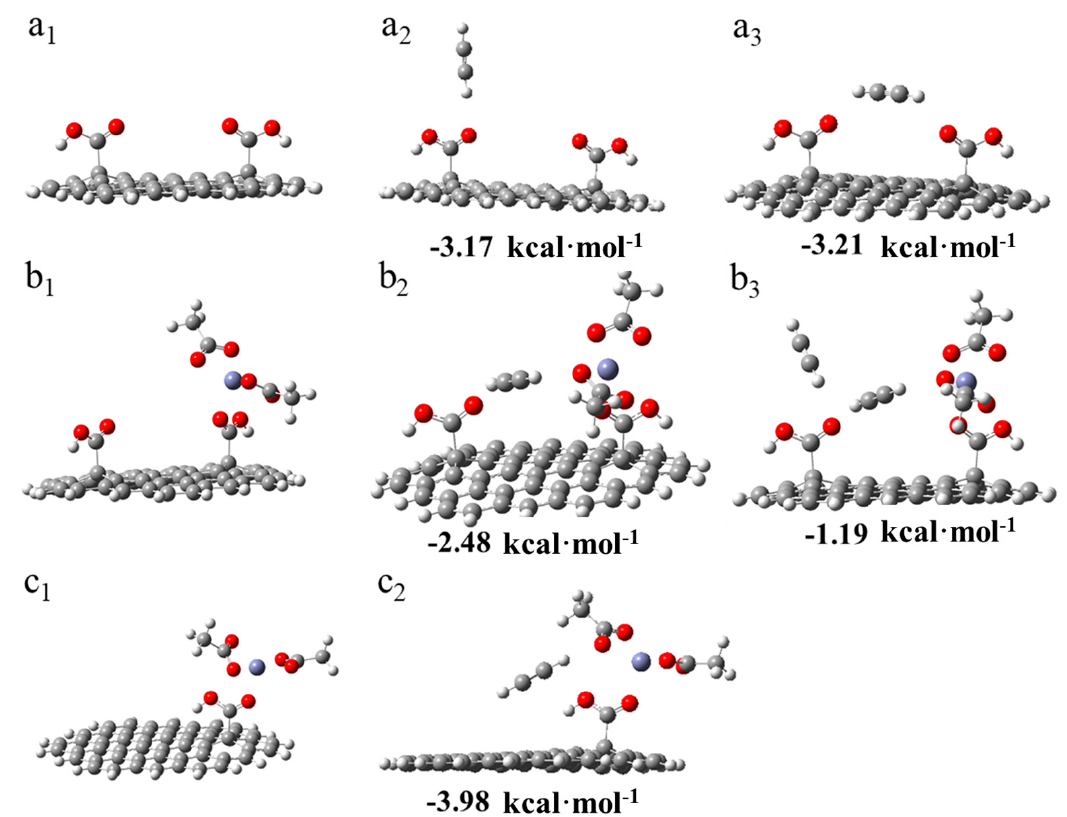
Figure 8. DFT results of the adsorptions of the acetylene molecule. ( a 1 ) Dicarboxylic substrate of AC. ( a 2 ) Adsorption of the acetylene molecule on the first –COOH group of AC with the dicarboxylic substrate (AC–II–COOH*). ( a 3 ) Adsorption of the acetylene molecule on the middle of AC with AC–II–COOH*. ( b 1 ) Adsorption of zinc acetate on dicarboxylic AC. ( b 2 ) First adsorption of the acetylene molecule between the –COOH group and another molecule, which was adsorbed zinc acetate. ( b 3 ) Adsorption of the second acetylene molecule. ( c 1 ) Adsorption of zinc acetate on monocarboxylic AC. ( c 2 ) Adsorption of acetylene on the monocarboxylic catalyst.